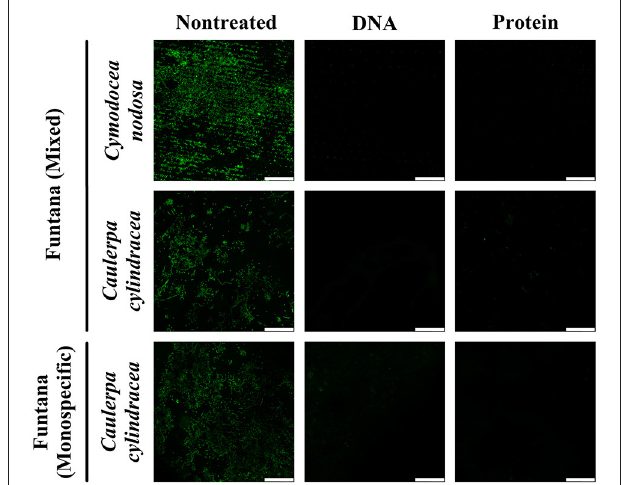
FIGURE 2 | Confocal microscope images of C. nodosa and C. cylindracea surfaces from the Bay of Funtana (mixed and monospecific settlements) sampled on June 19, 2018 and stained with SYBR Green I. Scale bar at all images is 60 µ